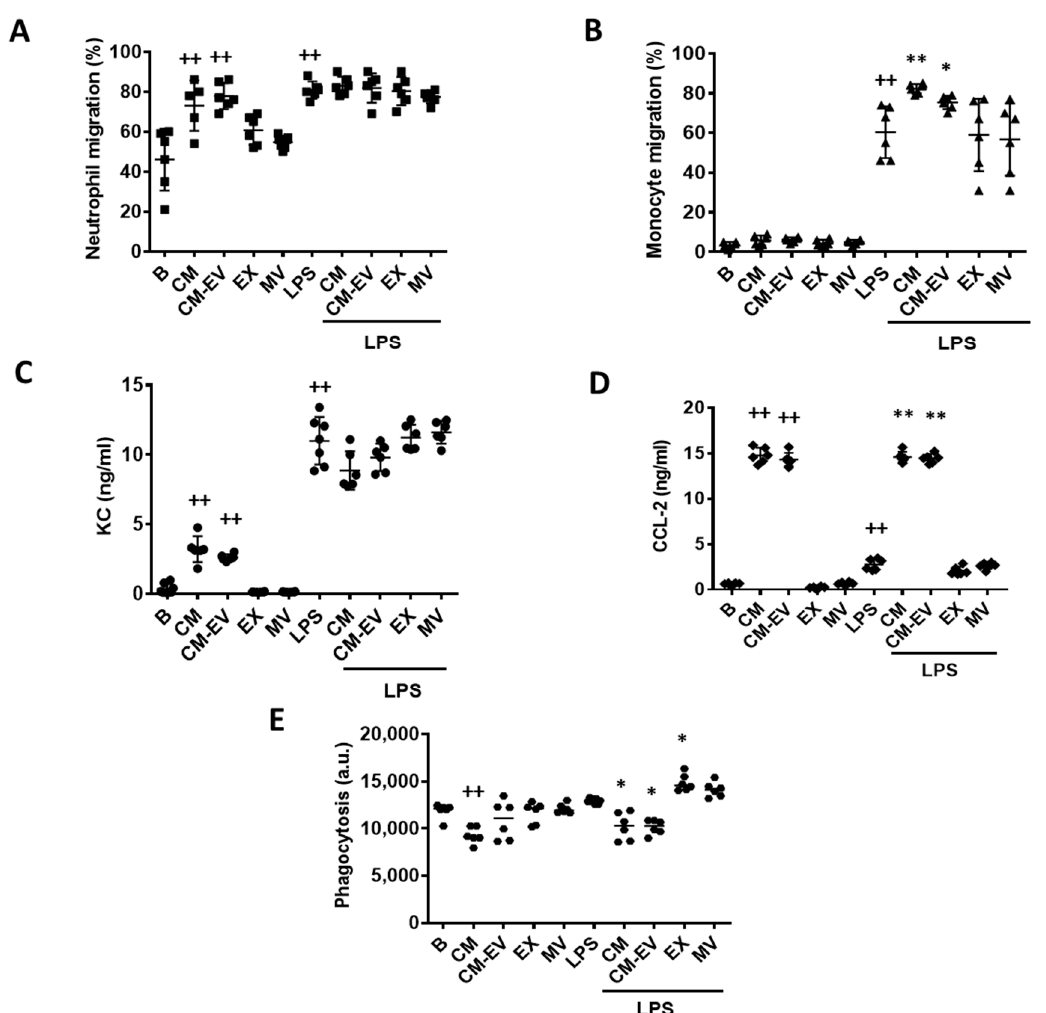
Figure 3. Macrophage functions. Neutrophil migration ( A ), monocyte migration ( B ), CXCL-1 levels ( C ), CCL-2 levels ( D ) and phagocytosis ( E ). For migration experiments, macrophages were incubated with CM, CM-EV, EX, or MV in the presence or absence of LPS for 20 h. Then, neutrophils or monocytes were added to the upper compartment of the transwells and after 4 h, the migrated cells were quantified by flow cytometry. CXCL-1 and CCL-2 were measured by ELISA in the supernatants of neutrophil or monocyte migration assays, respectively. Macrophage phagocytosis of fluorescent polystyrene beads was determined by flow cytometry. B: cells incubated with control medium and not stimulated with LPS. Data are presented as mean ± SD ( n = 6) from 3 independent experiments. One-way analysis of variance followed by Tukey’s post hoc test; ++ p < 0.001 versus B; * p < 0.05, ** p < 0.01 versus LPS control.